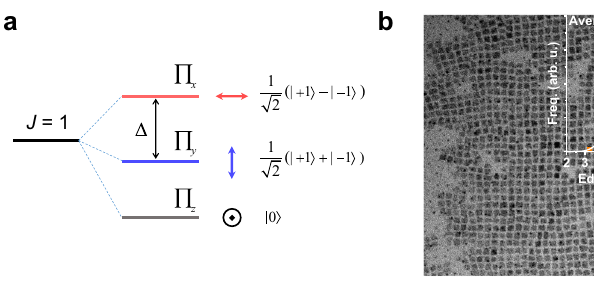
directionandhencethespinpolarizationarealongthe z -axis. Δ denotestheenergy splitting between the Π x and Π y states. b Transmission electron microscopy image ofCsPbBr 3 NCs.Insetplotshowsthesizedistribution.Theblackscalebaris50nm. c Room-temperature steady-state absorption and PL spectra of a NC5